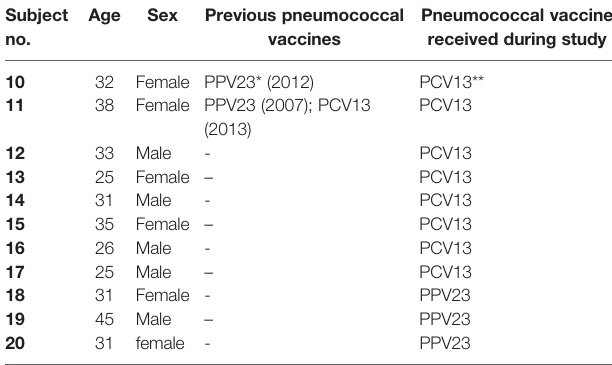
TABLE 2 | Description of study participants including previously administered pneumococcal